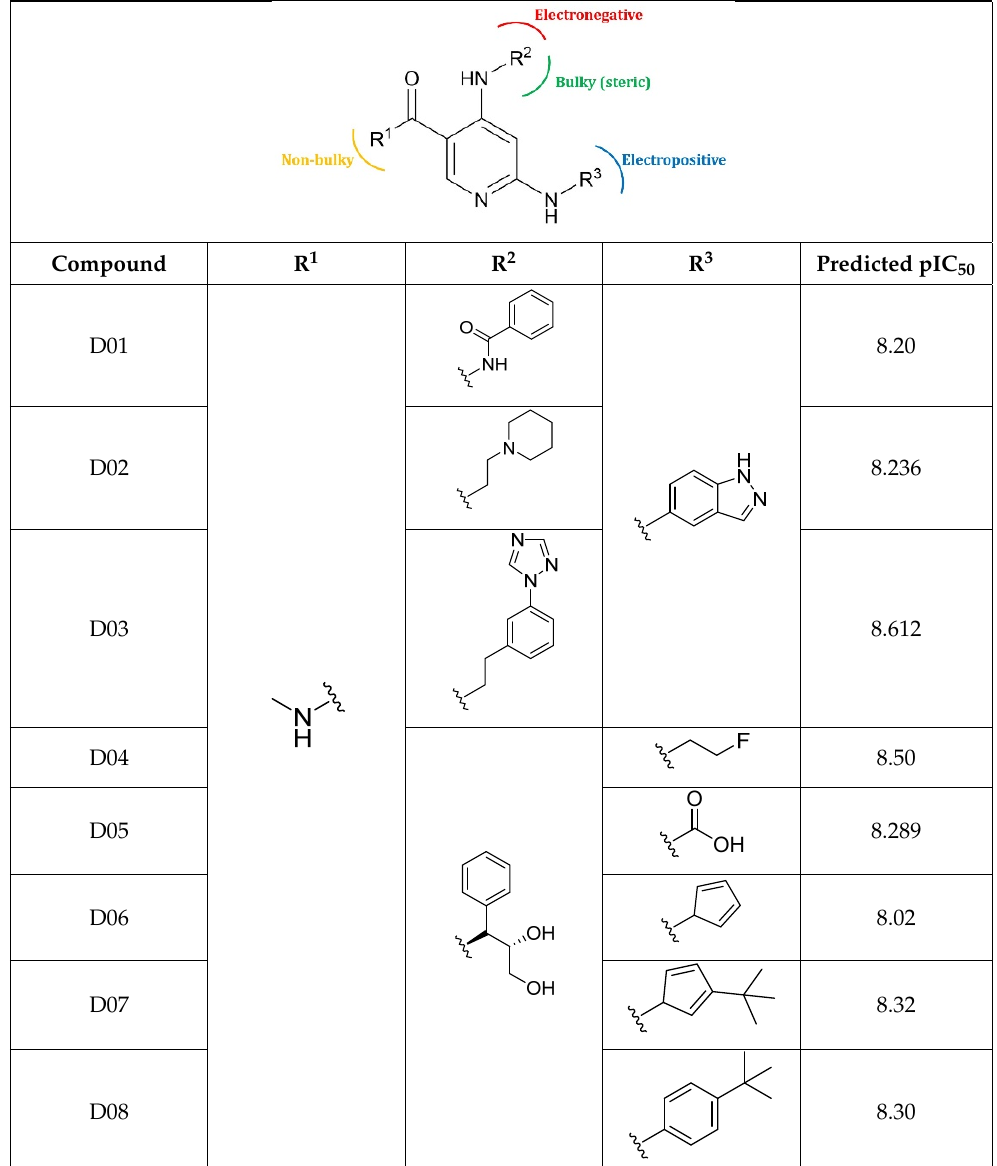
Table 2. The structures and the predicted pIC 50 values of the designed IRAK4